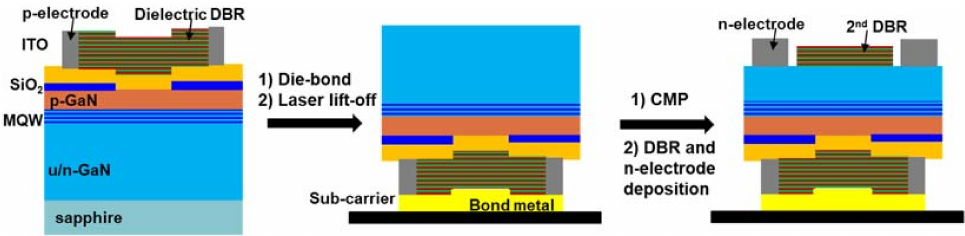
Figure 7. Schematic fabrication process of firstly demonstrated dual-type nitride